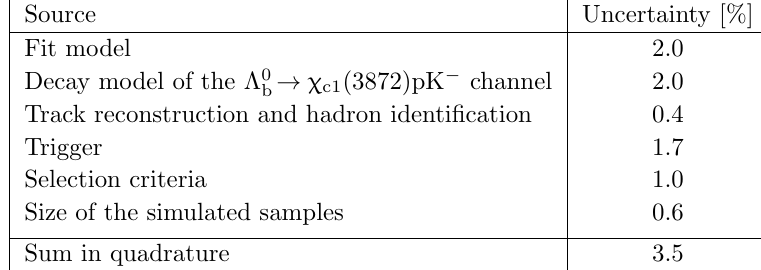
Table 1 . Relative systematic uncertainties for the ratio of branching